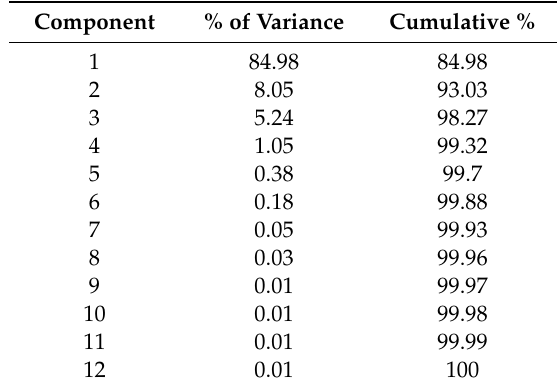
Table 2. Result of the PCA method for the pre-processing of Titicaca lake water level data.